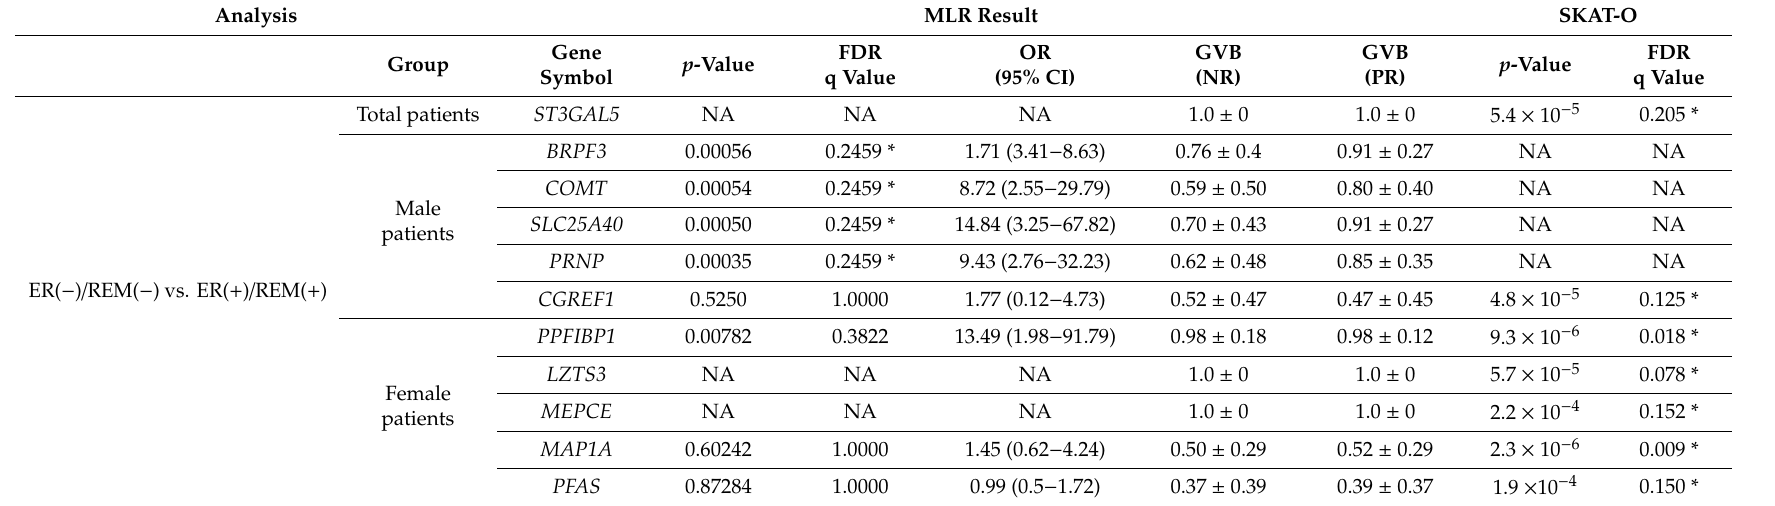
Table 2. Candidate genes for later non-remission in depressive patients exhibiting poor early improvement.